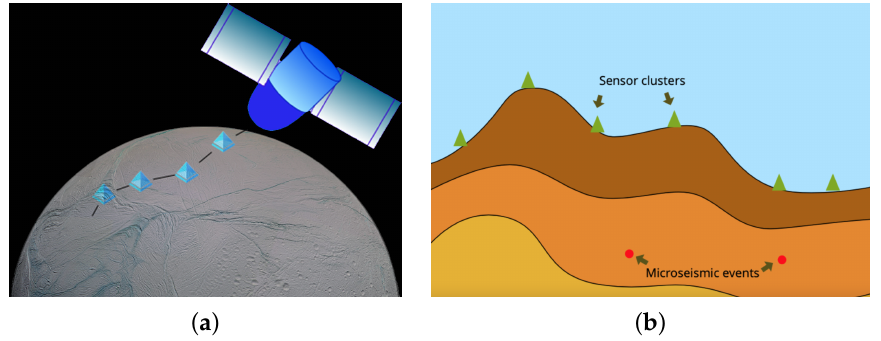
Figure 2. ( a ) Dropping the cabled sensor clusters from a low-altitude aircraft. ( b ) The 2D model for seismic event localization with topographic